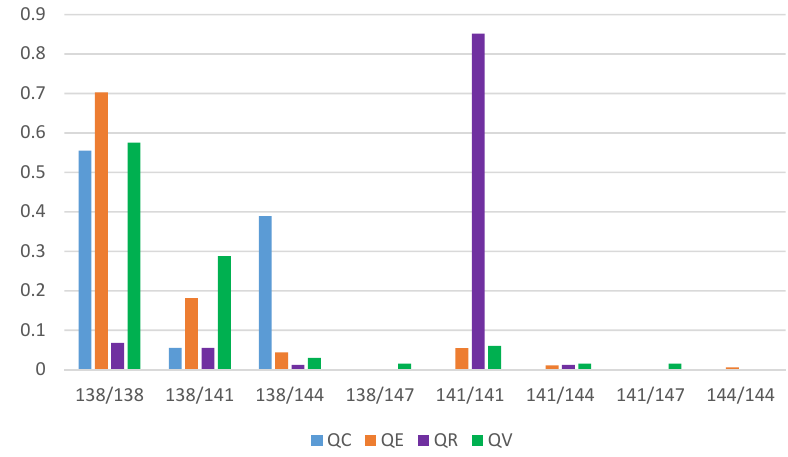
Figure 3. Relative genotypic frequencies in four oak species at the FIR013 locus.